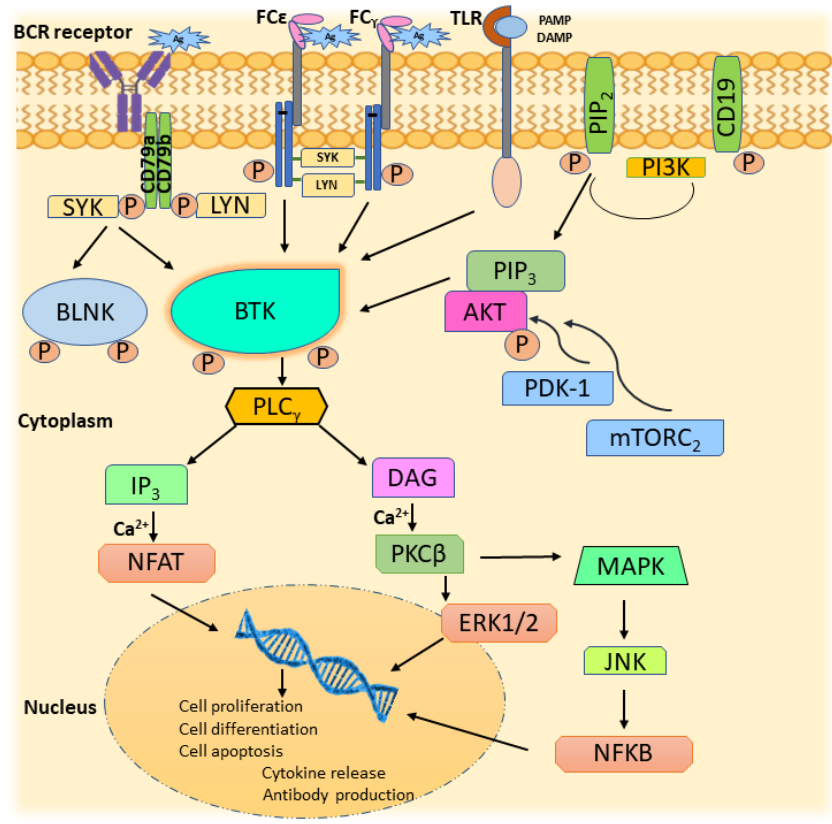
Figure 3. BTK in BCR signaling.